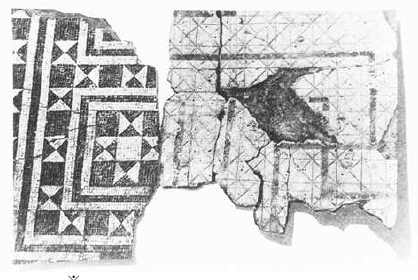
Fig.13 ※ a remained guideline under